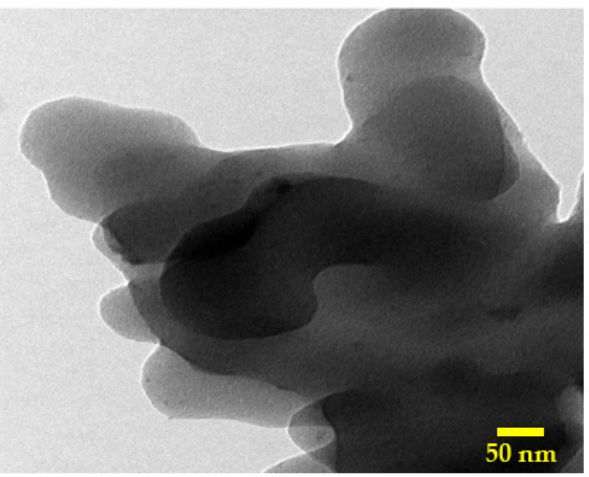
Figure 5. TEM image for the obtained activated carbon using H 3 PO 4 /KOH mixture (14 mL sample).